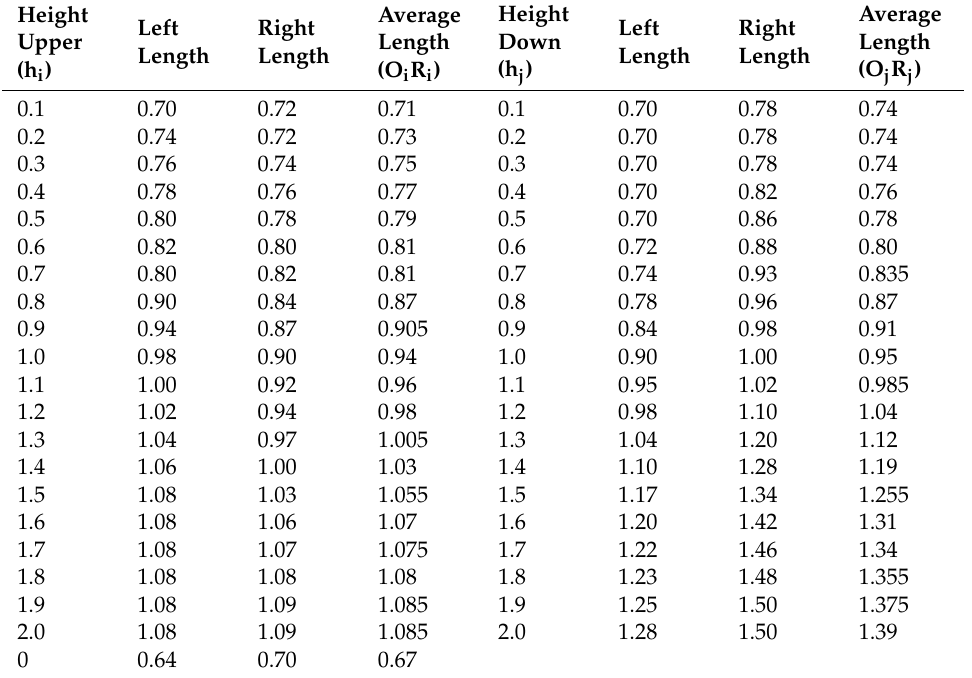
Table A5. Cross-sectional profile of case S6 weld seam. (Unit: